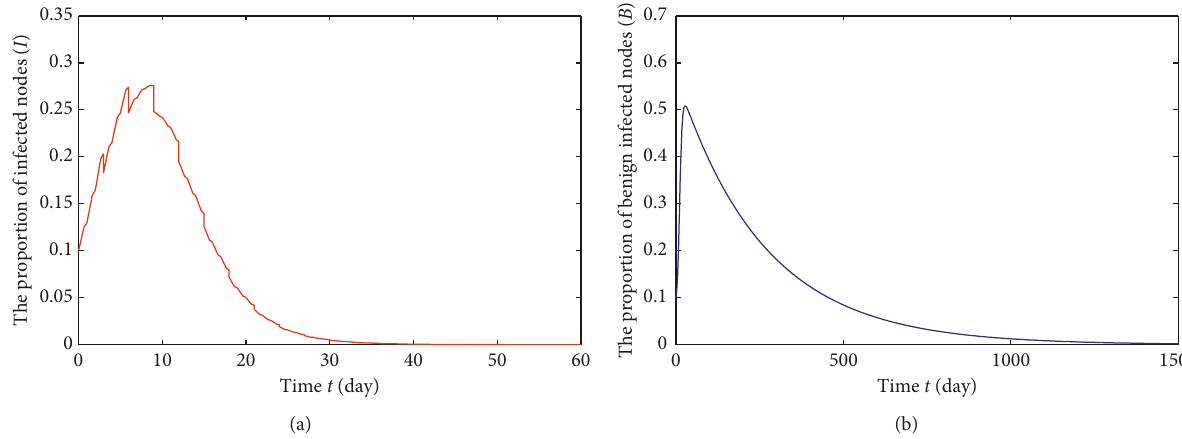
Figure 1: Evolution of I ( t ) and B ( t ) for system (5). R